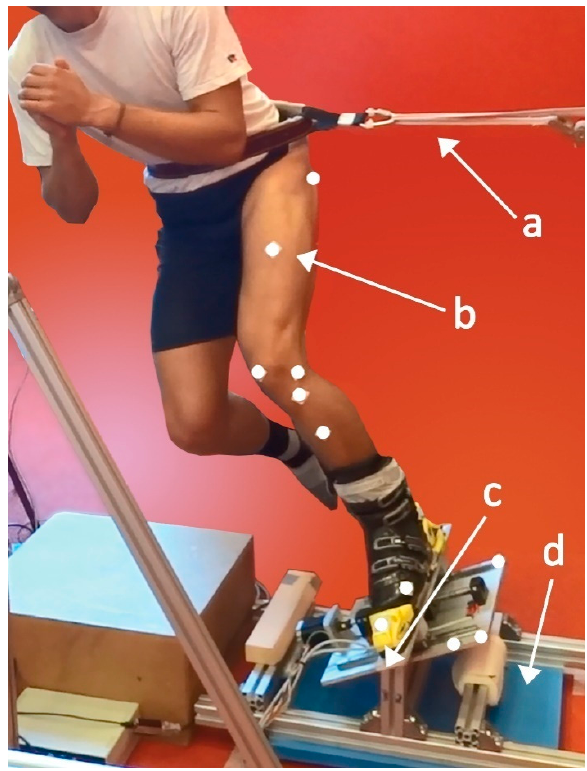
Figure 1. A ski turn simulator with a participant: ( a ) lateral supporting strap with pressure / tensile force gauge; ( b ) optical marker; ( c ) axis of rotation; ( d ) force plate.